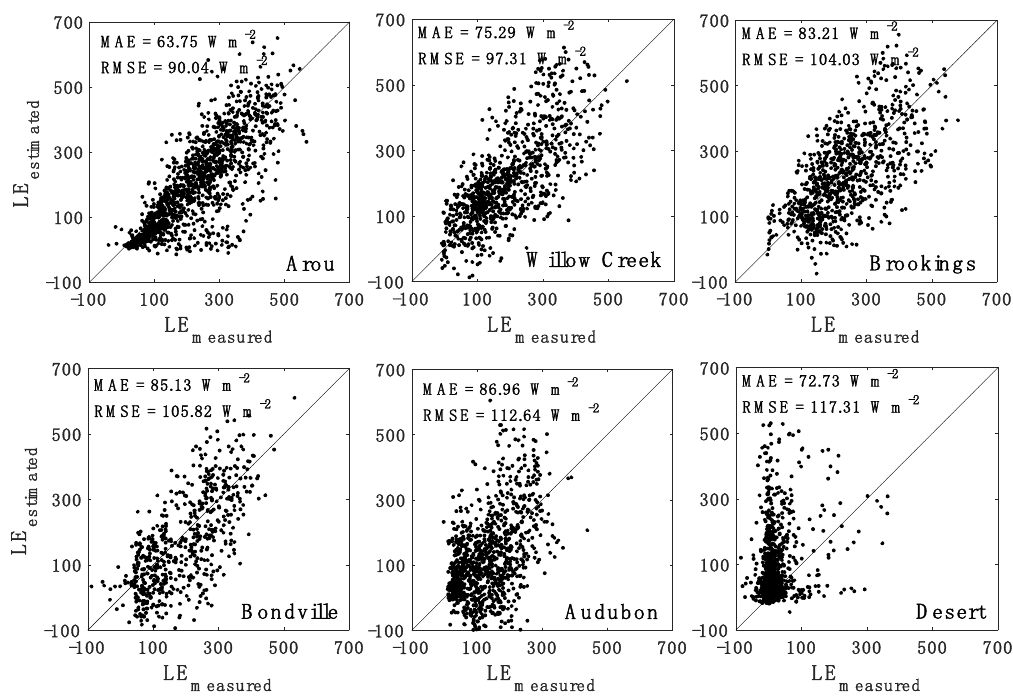
Figure 6. Scatterplot of half-hourly latent heat flux ( LE ) estimates versus observations at the six investigated sites.